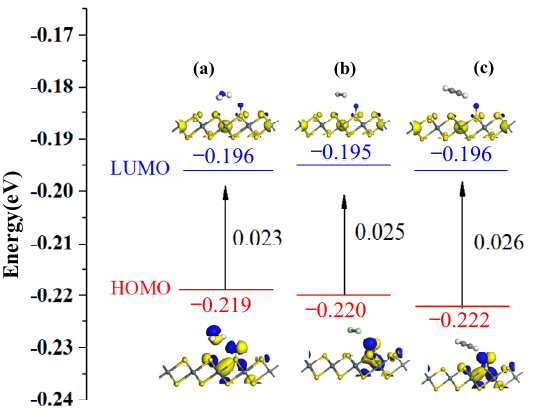
Table 5. Energy of HOMO, LUMO, and energy gap of N-SnS 2 and adsorption systems.